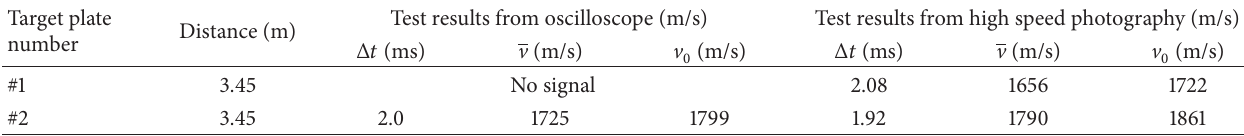
Table 2: Fragment velocity test results of concave-120 ∘